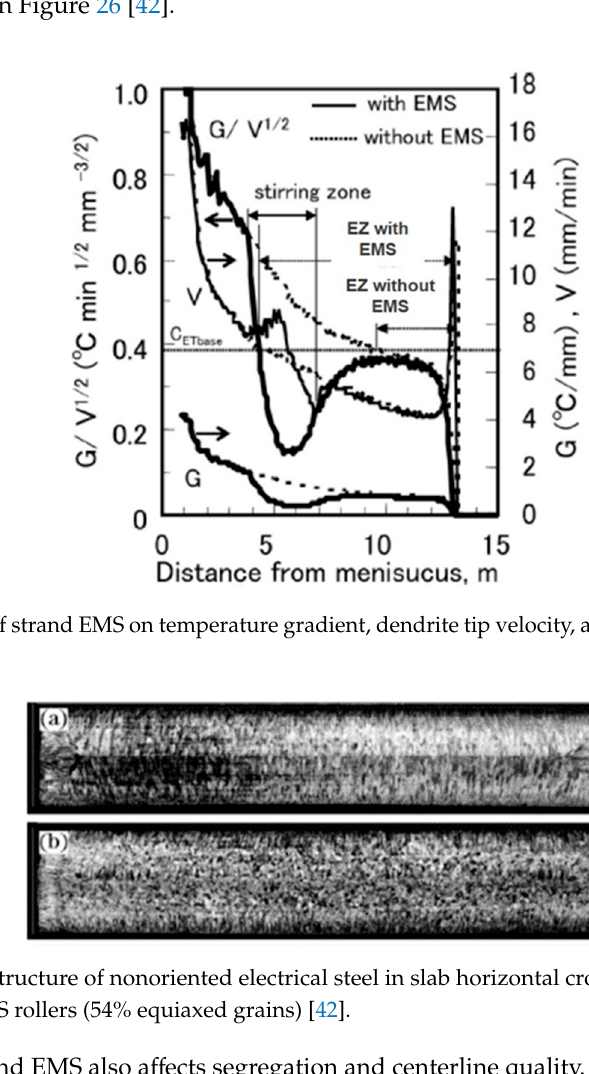
Figure 27. Effects of SEMS with soft reduction on segregation and porosity defects [43]. However, white bands (low solute concentration) and/or dark bands (high solute concentration) in the steel microstructure are caused by tangential flow across the solidification front, due to nonuniform solute distribution in the strand region. These distinctive bands of macrosegregation can be seen in slabs cast with SEMS, always at the depth into the slab where the flow was induced [147],